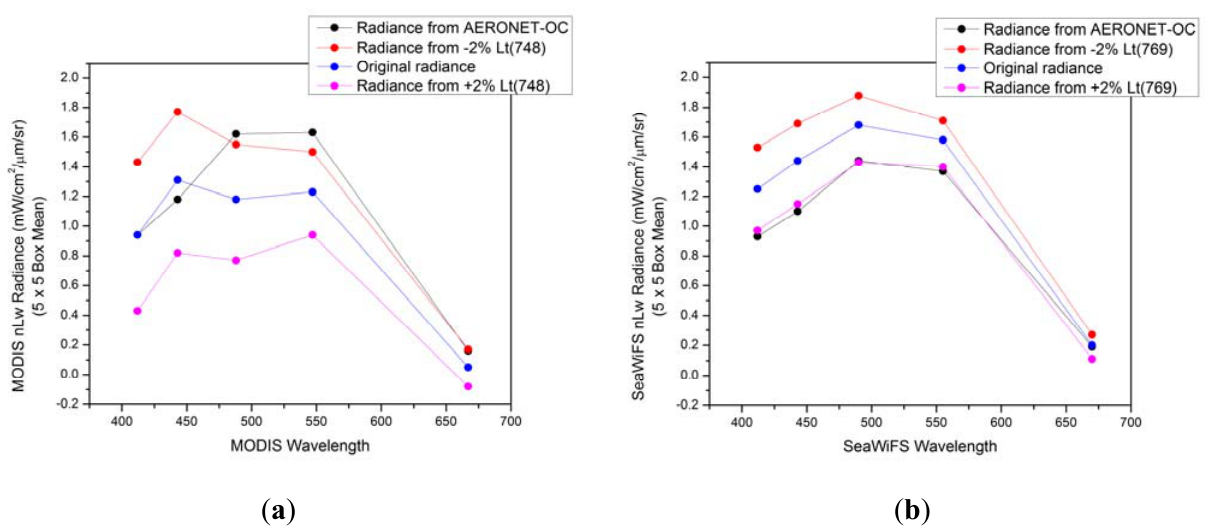
Figure 15. L ( λ ) spectral variability related to the addition of noise, 16 April 2010, n w Venice AERONET-OC site. ( a ) Original and adjusted (±2%) L ( b ) SeaWiFS L t